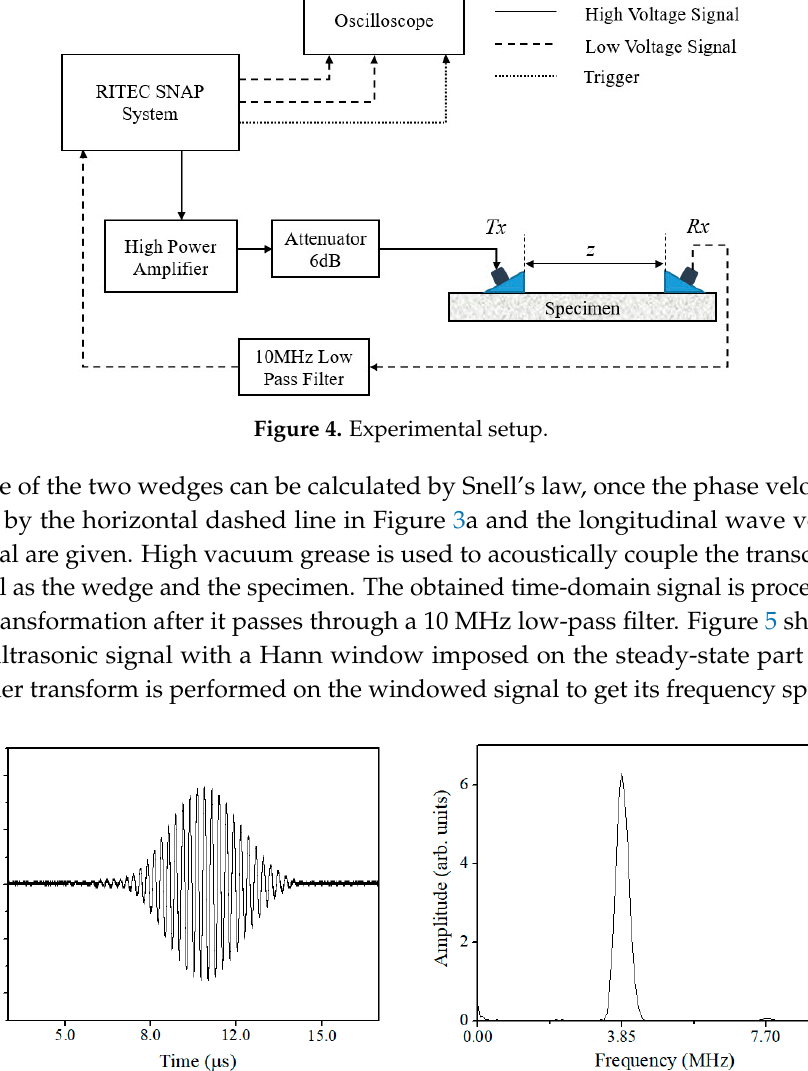
Table 1. Chemical composition (wt %) of 201 stainless steel.